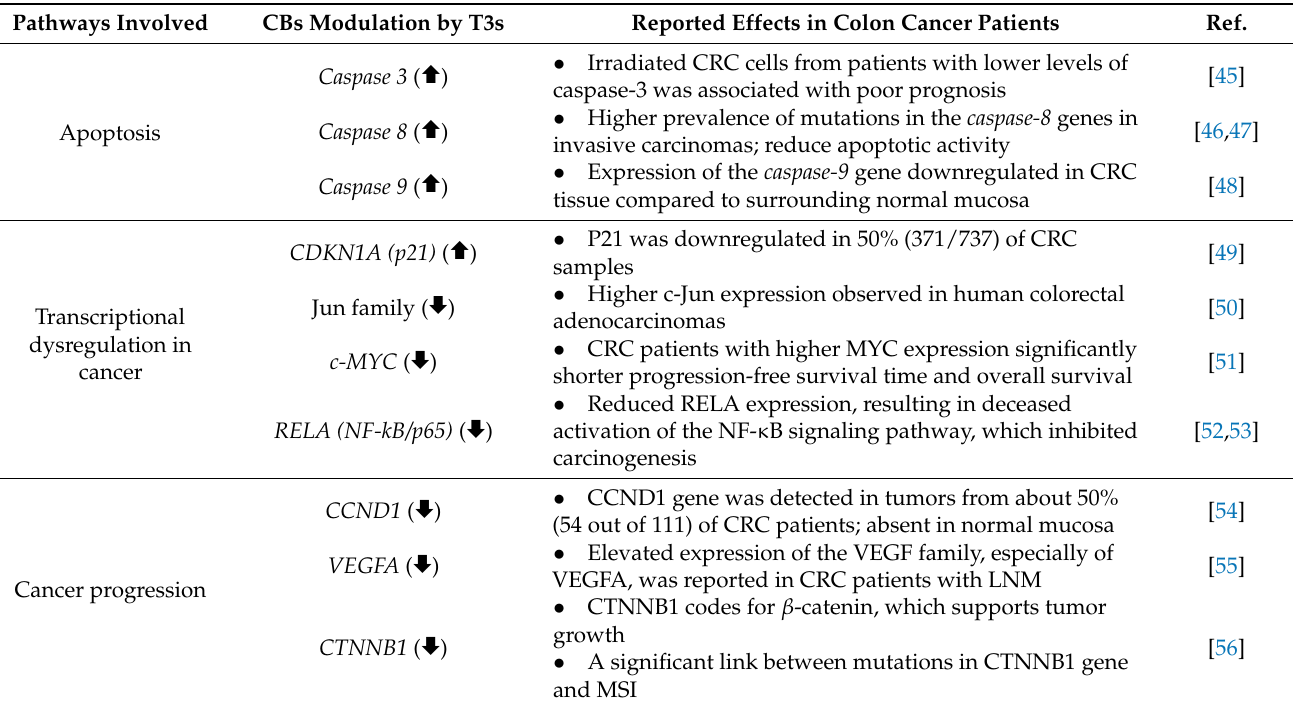
Table 2. Summary of clinically relevant genes and proteins modulated by tocotrienols in human colon cancer cell lines. Pathways Involved CBs Modulation by T3s